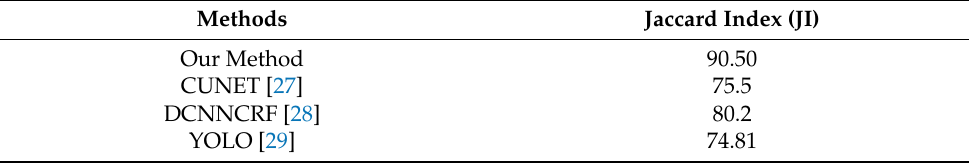
Table 3. Performance analysis (%) based on the Jaccard Index for only the proposed method with existing probability-based methods on the ISBI 2017.